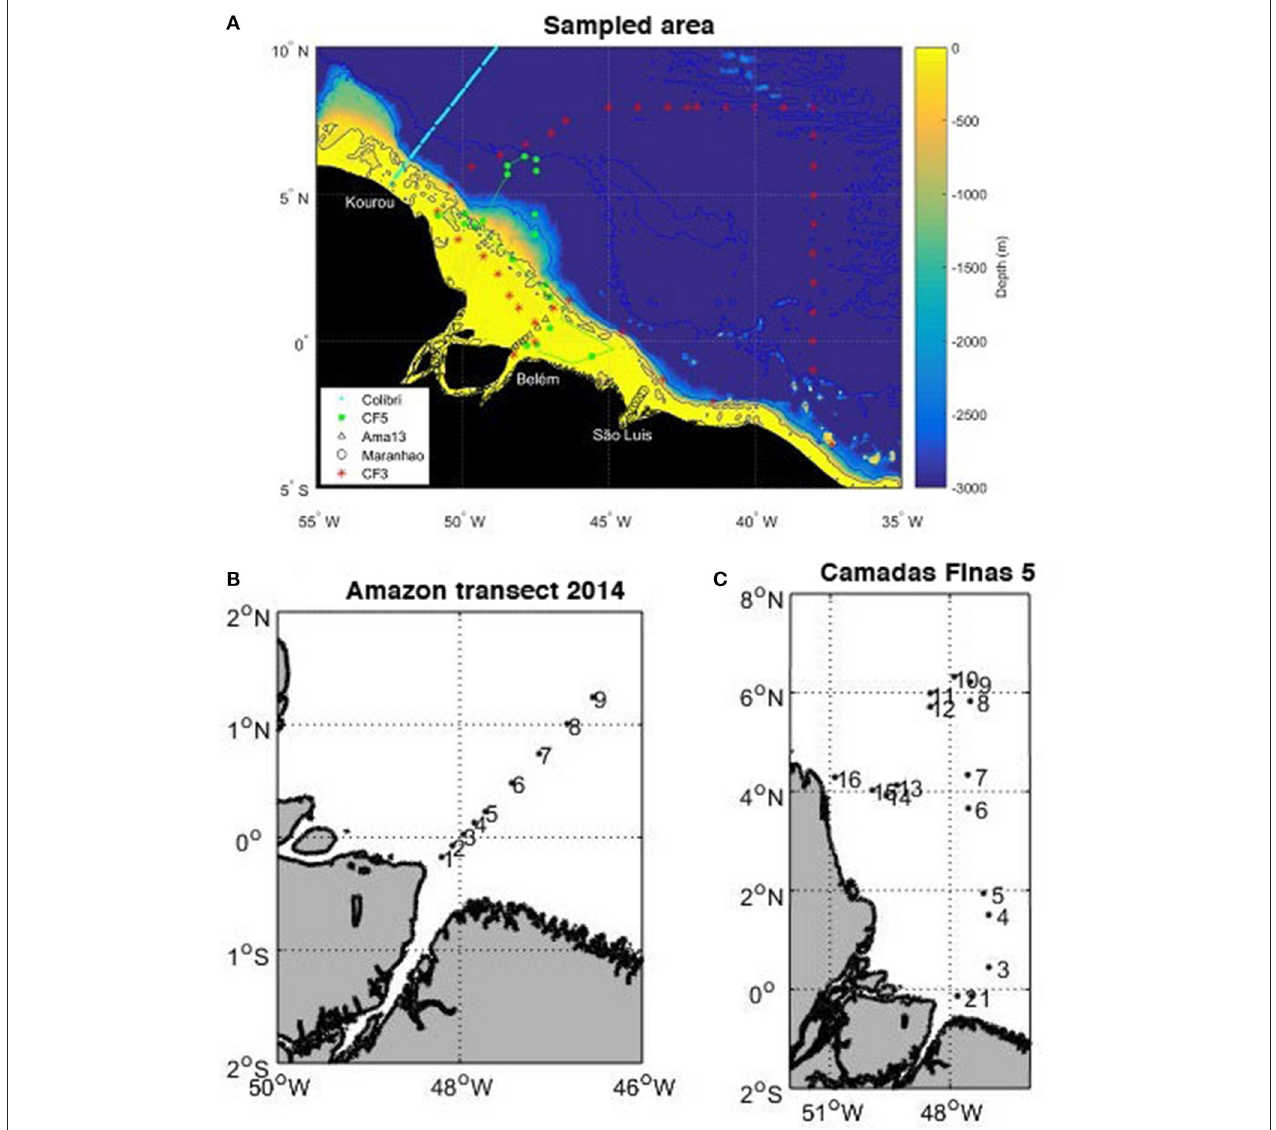
FIGURE 1 | (A) Map of the cruises superimposed on the bathymetry: voyages of the MN Colibri (cyan), Camadas Finas 3 (red stars), Camadas Finas 5 (magenta with dots corresponding to the stations), Amazon transect (black triangles), transect of the Maranhense gulf (black circles), and positions of temperature and salinity samples (green dots). The bathymetry is generated with ETOPO2 2-min gridded global relief data, National Geophysical Data Center, 2006. 2-min Gridded Global Relief Data (ETOPO2) v2. National Geophysical Data Center, NOAA. doi:10.7289/V5J1012Q. (B) Position of the nine stations sampled on the transect in May 2014. (C) Position of the 16 stations sampled during the Camadas Finas 5